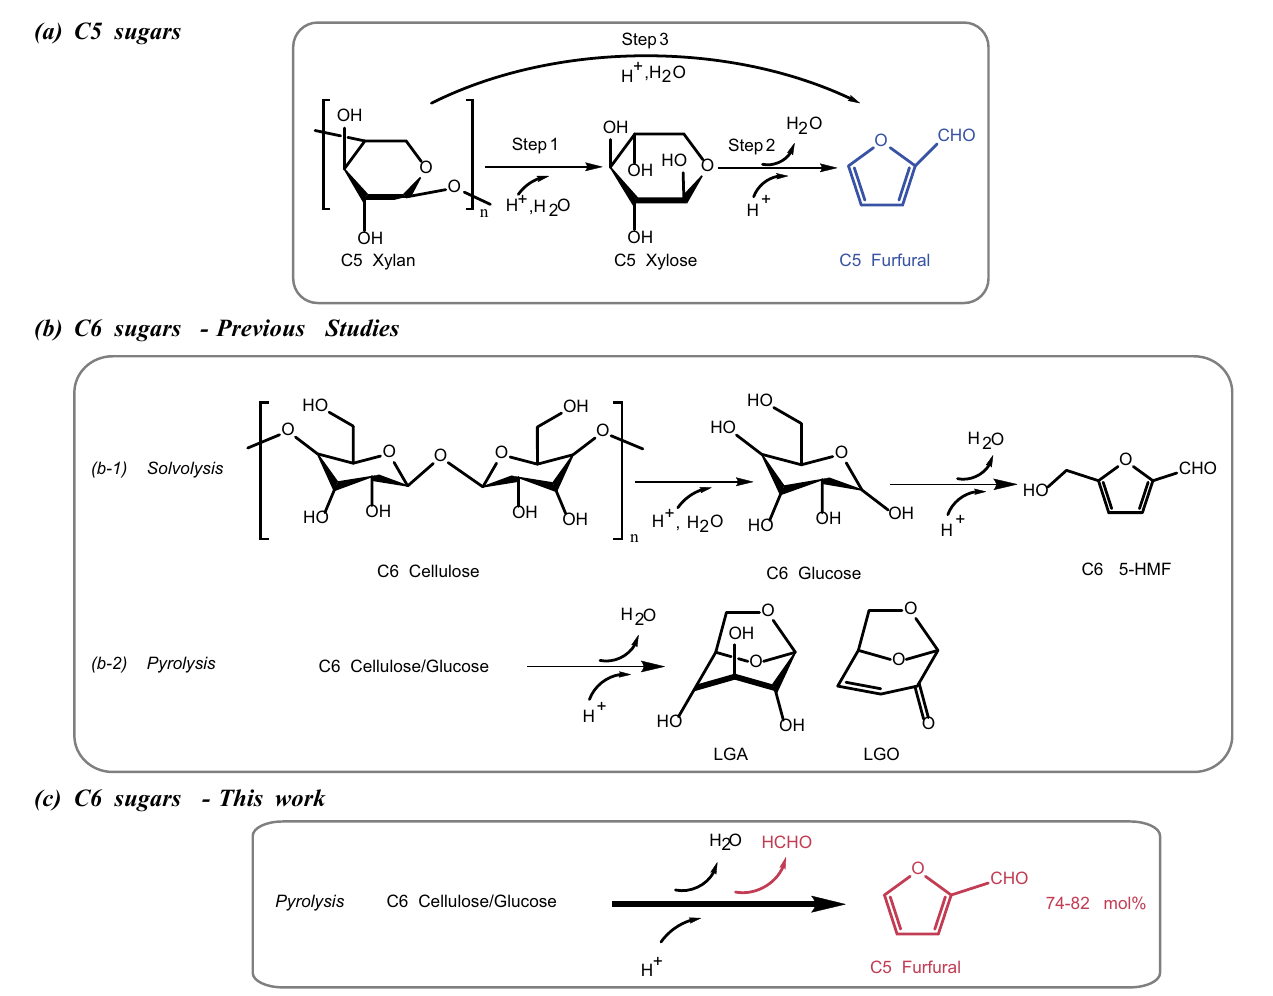
Fig.1|Reactionpathwaysofdifferenttypesoffeedstocks. Panel a forC5sugarsbysolvolysisandpyrolysis.Panel b forC6sugarsbysolvolysis(b-1)andpyrolysis(b-2); and Panel c for the conversion of C6 sugars by catalytic pyrolysis with the Pd-PdO/ZnSO 4 catalyst developed in this